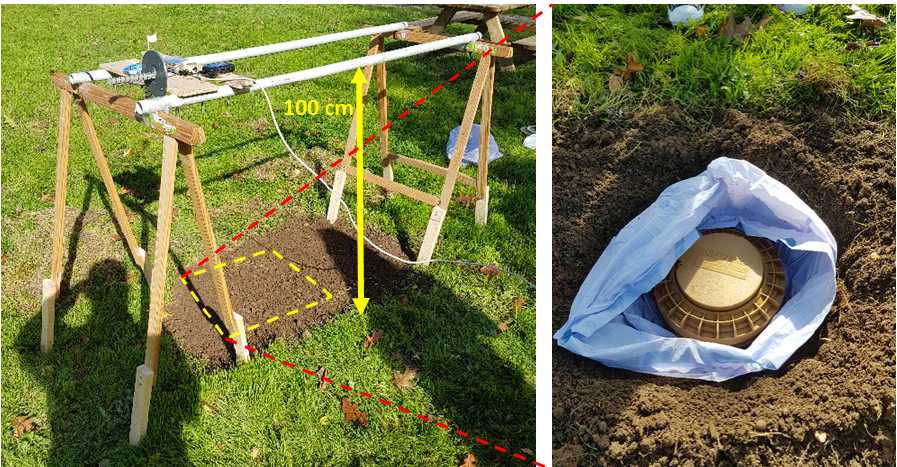
Figure 12. Picture of a 2D-measurement setup (acquisition along x axis). A picture of the anti-tank plastic landmine can be seen in the right picture.